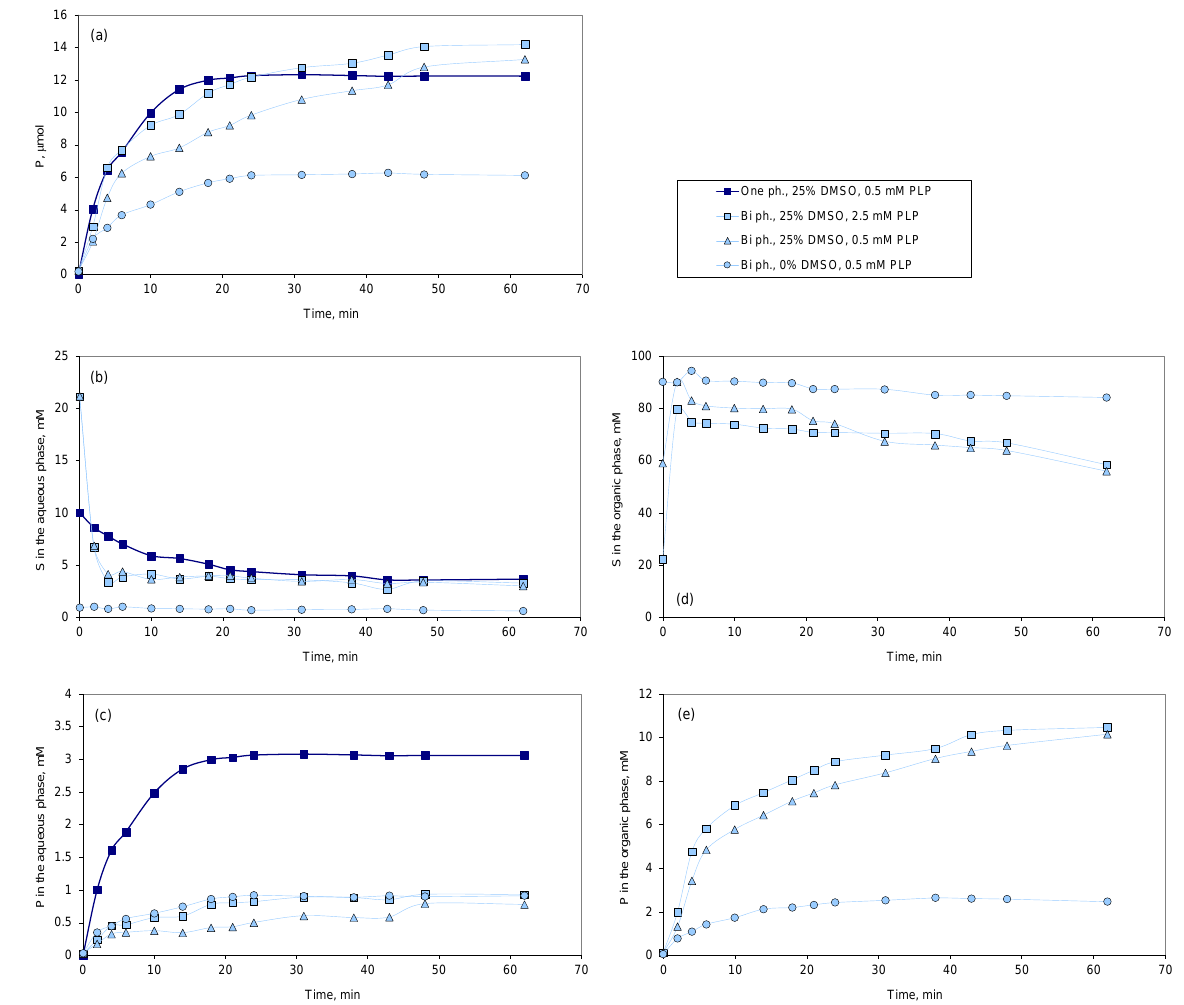
Figure 4. Effect of DMSO and PLP on the conversion of 4′-(trifluoromethyl)acetophenone (S) into 4-trifluoromethylphenyl)ethylamine (P) in single aqueous (one ph.) and organic:aqueous phase (bi ph.) systems: ( a ) total quantity of P produced; S and P concentrations in the aqueous phase ( b and c , respectively) and in the organic phase ( d and e , respectively) of the biphasic system.